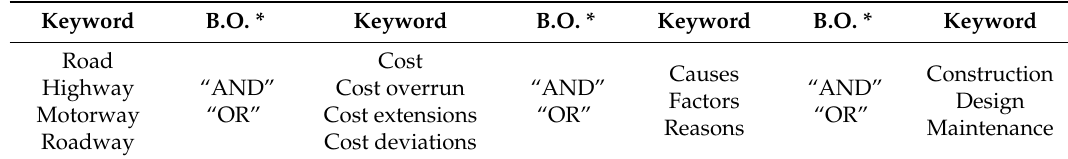
Table 1. Keywords and Boolean Operators used to locate relevant